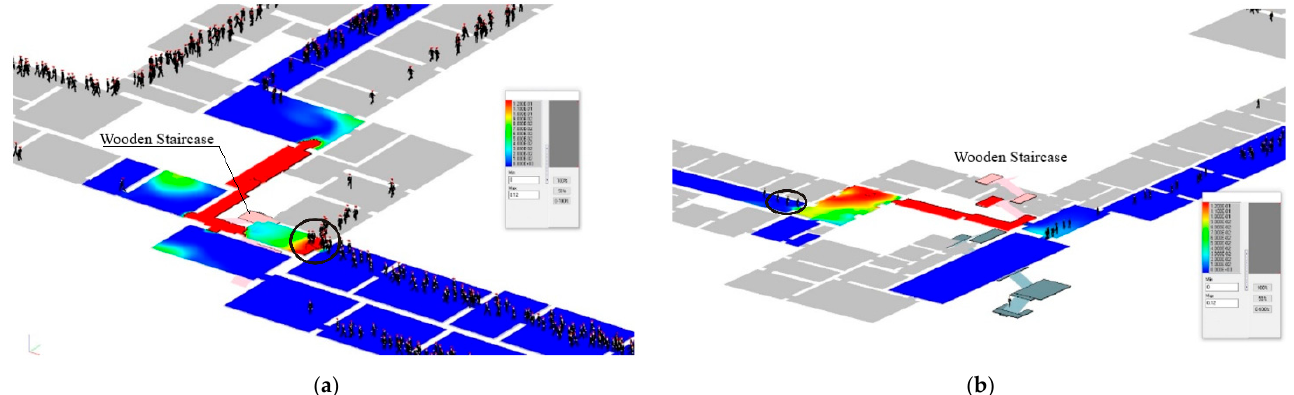
Figure 11. Horizontal slices of smoke (Np/m) at a height of 1.7 m from the floor and evacuation in the scenario “The fire in the foyer of the Wooden Staircase” (the color changes from blue (safe) to red (dangerous), the critical value of the optical density of smoke is given in the Table 1): ( a ) Equation (1) is not true for the 3d floor; ( b ) Equation (1) is not true for the 2d floor.